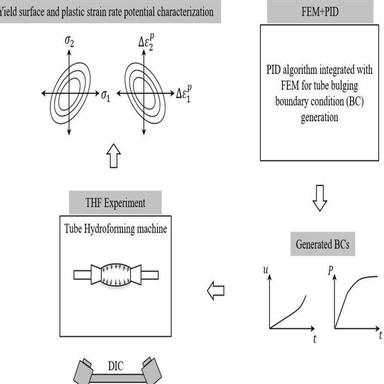
Proposed offline boundary conditions generation for tubular material characterization.